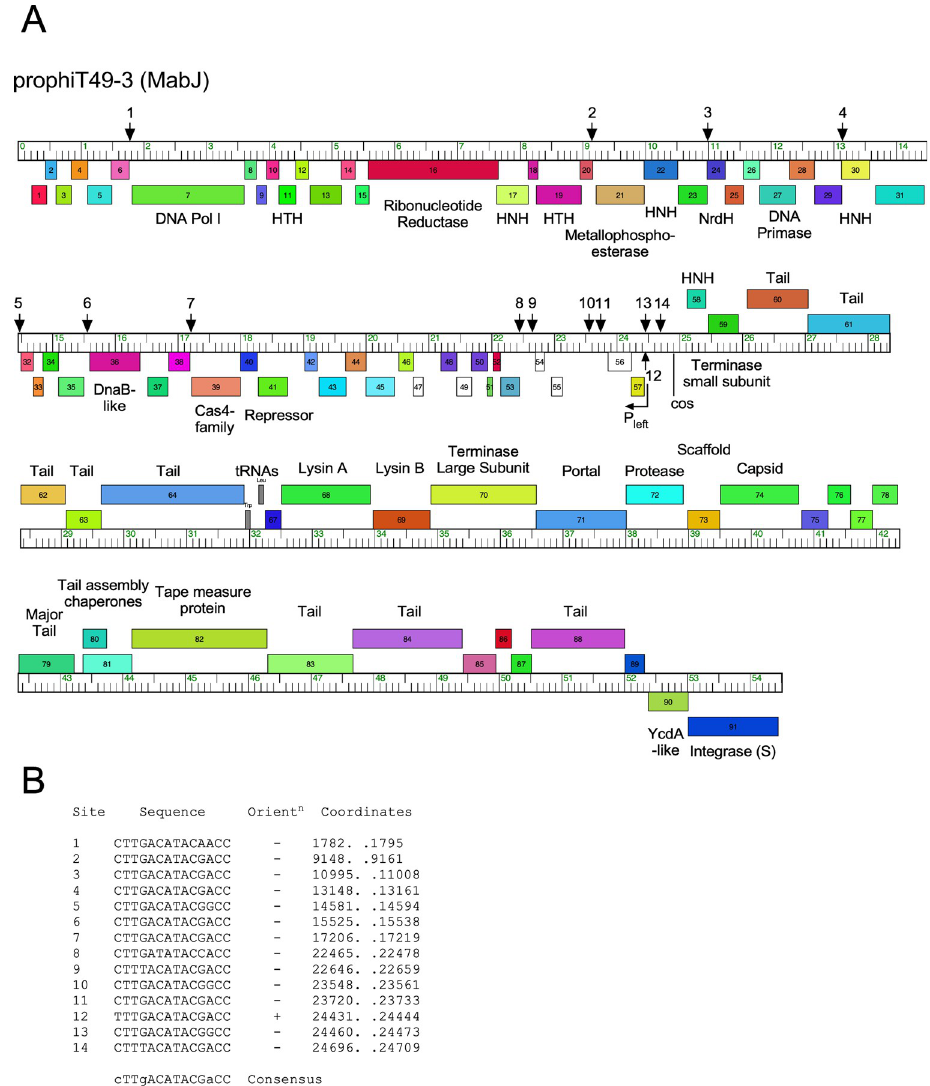
Fig 8. Repressor binding sites in MabJ prophage prophiT49-3. A . Genome map of prophiT49-3. The genes are displayed as described in Fig 3 and putative functions are shown, where known or predicted. The vertical arrows show the positions of predicted repressor binding sites. Site #12 overlaps the predicted early lytic promoter, P left , and is likely a true operator site. The other sites are all in the opposite orientation to site #12 and represent ‘stoperator’ sites where repressor binding is proposed to interfere with transcriptional elongation. B . Sequences of operator and stoperator sites showing their genome coordinates, orientation, and consensus sequence. Consensus positions conserved in all sites are shown in upper case type, and those present in at least ten of the sites are shown in lower case